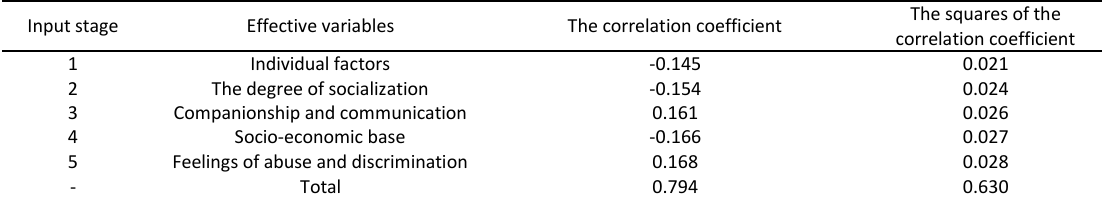
Table 8: Input phases and output results of variables in regression analysis